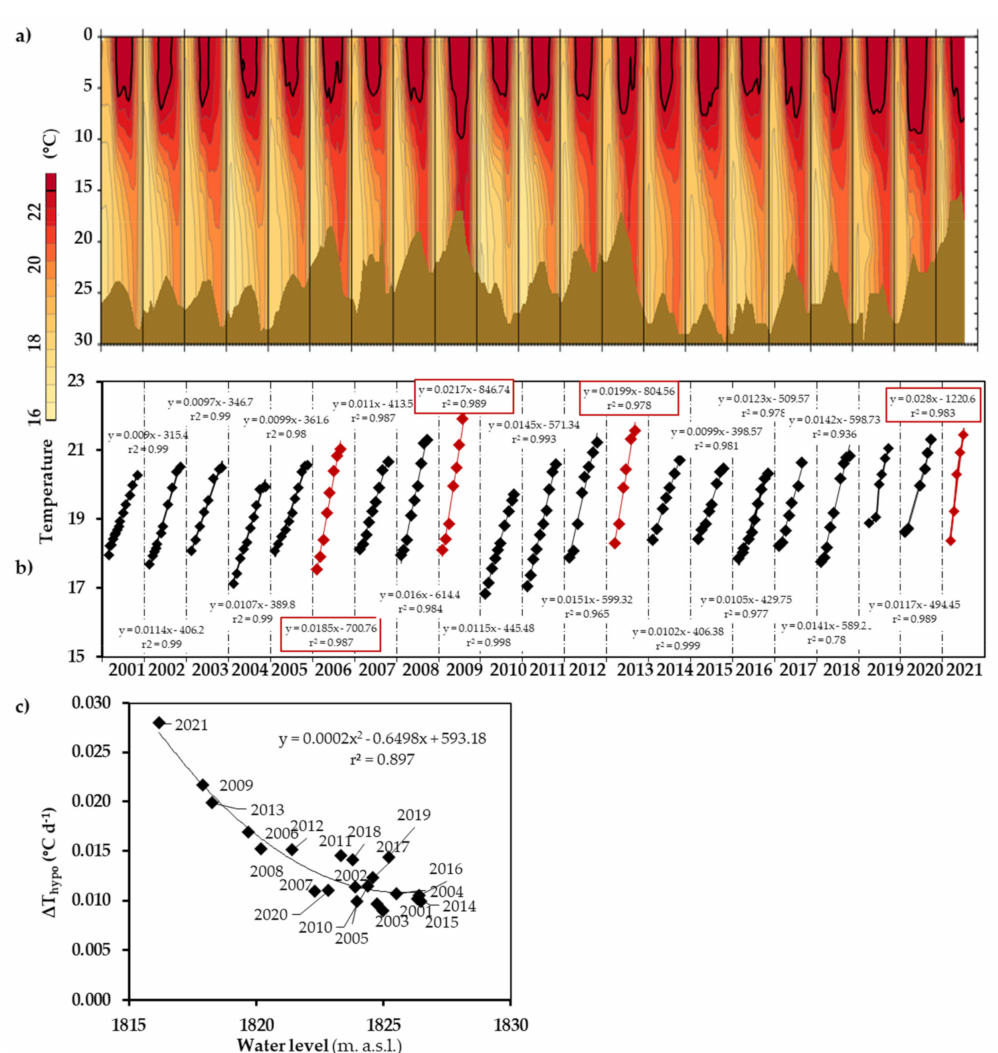
Figure 4. Temperature distribution and hypolimnetic water warming in VB during 2001–2021: ( a ) temporal evolution of the vertical distribution of temperature ( ◦ C) in this reservoir lake, in which the 22.5 ◦ C isotherms is used to outline the epilimnion; ( b ) hypolimnetic temperature variation ( ◦ C) during each stratification period sampled from 2001 to 2021 (the slopes of the regressions were used to assess the mean warming rate for each of the stratifications), in which the four years with extraordinary minimum water levels (2006, 2009, 2013, and 2021) are outlined in red; ( c ) variation in the mean hypolimnetic temperature increase rate ( ◦ C day − 1 ) as a function of the minimum annual water level throughout